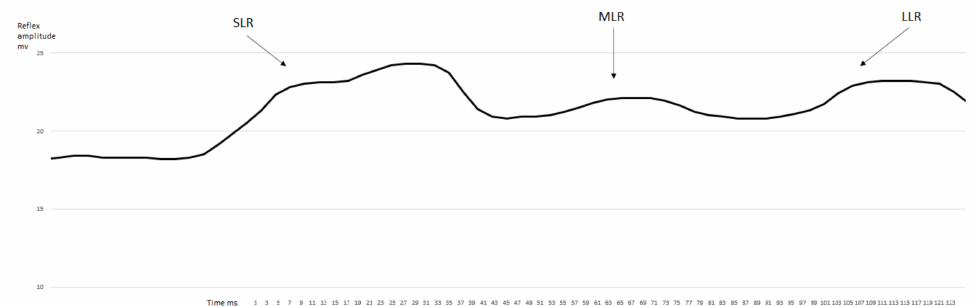
Figure 1. Representative rectified, filtered, and smoothened curve of the EMG activity for the rectus femoris muscle before the fatiguing protocol.